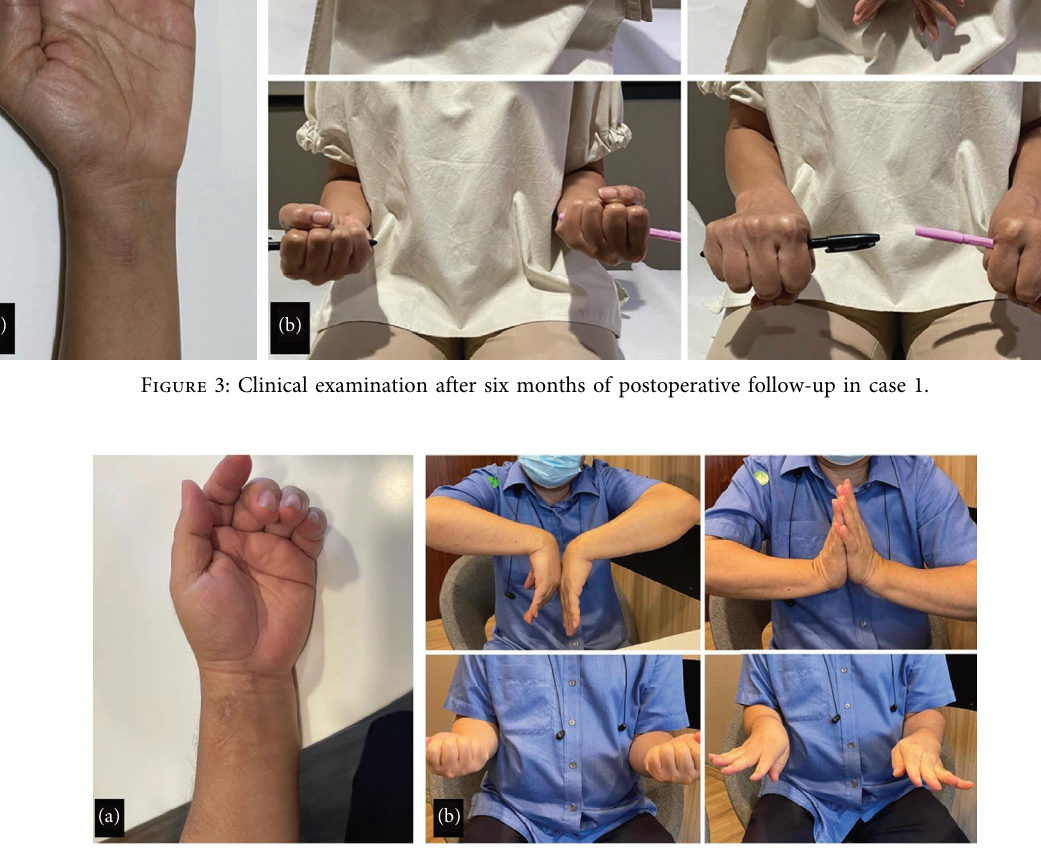
Figure 4: Clinical examination after six months of postoperative follow-up in case 2. Table 3: Surgical outcomes of subjects treated with MIPO at their postoperative and 3-month follow-ups.